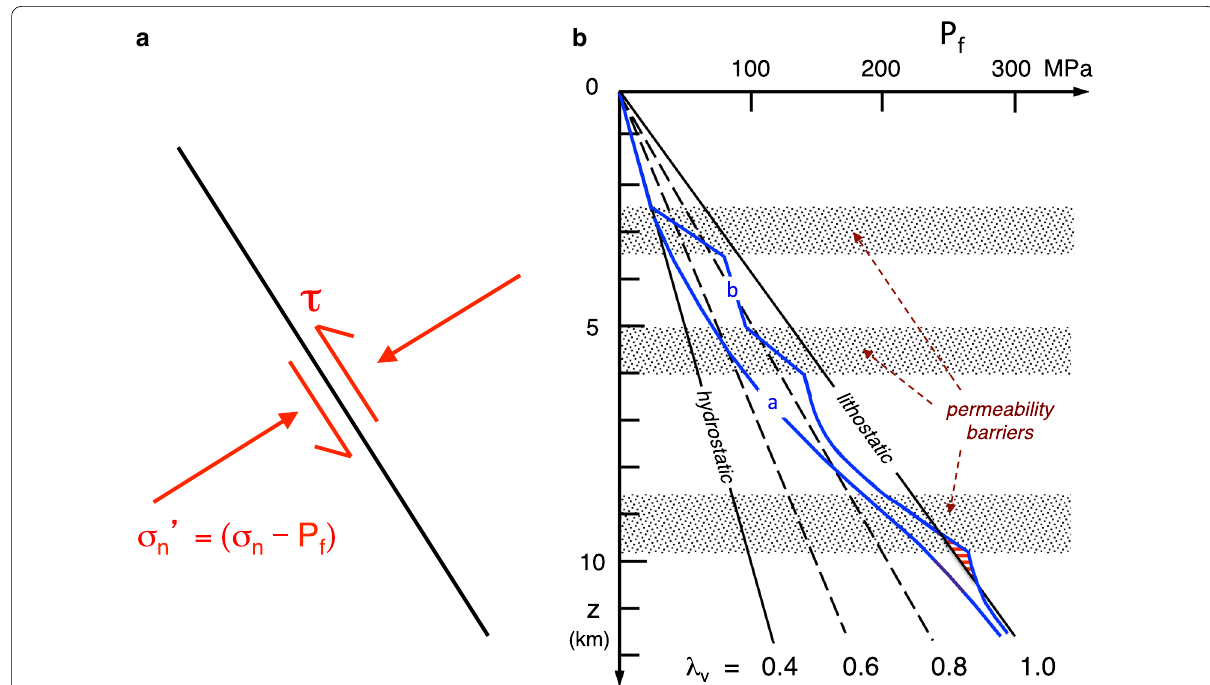
Fig. 1 a Components of shear stress, τ , and normal stress, σ n , acting on a fault; b hypothetical profiles of pore-fluid pressure, P f , versus depth, z , within the crust and in crustal fault zones shown in relation to the pore-fluid factor, λ v . Profile a assumes a smooth progression from hydrostatic towards lithostatic pressure as permeability steadily reduces with increasing depth; profile b is affected by the presence of low-permeability barriers (area of cross-hatching notes region of supralithostatic pore pressure). Note that the fluid-pressure profile inside a fault zone may differ from that in the wallrock